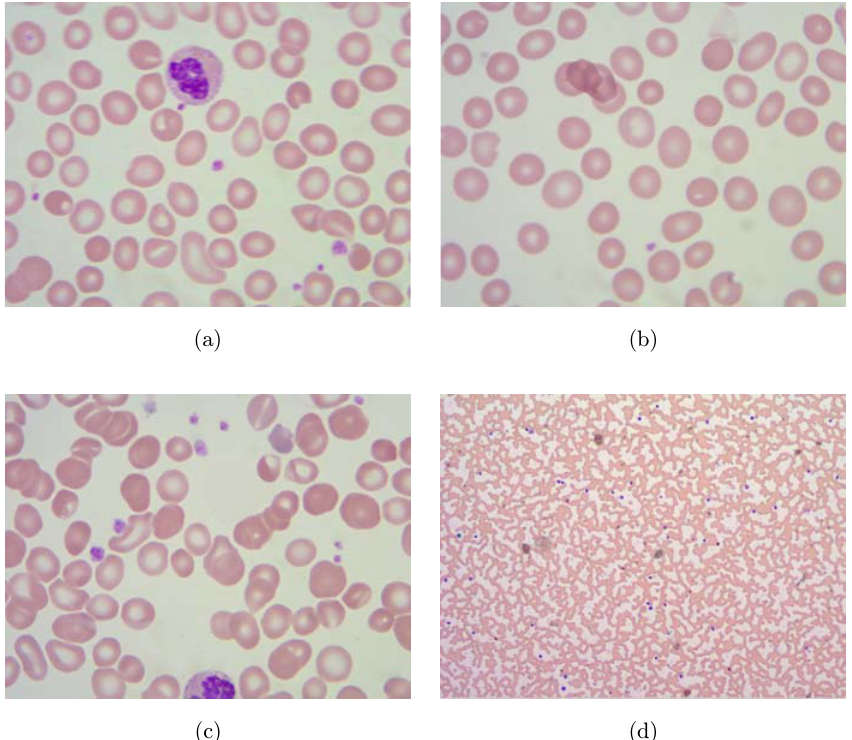
Fig. 1. Captured images while scanning at di®erent power objectives. (a) Expected leukocyte image (b) Image without any leukocyte (c) Image with an incomplete leukocyte (d) Captured low power